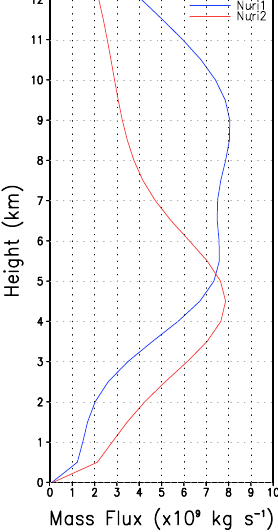
Figure 15. Vertical mass flux profiles calculated over the observational domain derived from the SAMURAI analysis for Nuri 1 (blue) and Nuri 2 (red).